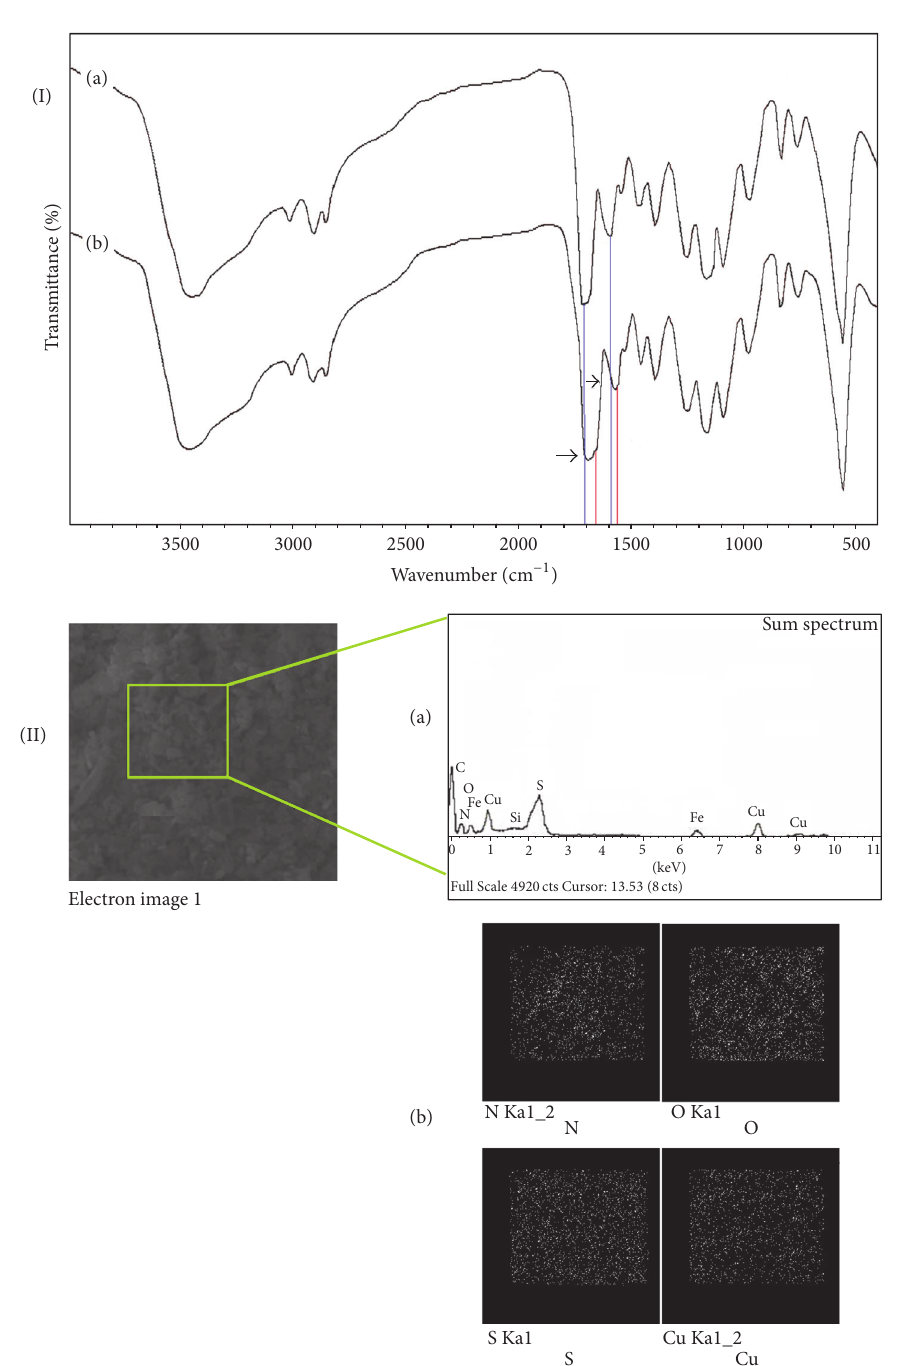
Figure 10: (I) FT-IR spectra of (a) prepared magnetic nanocomposite and (b) complex of nanocomposite-Cu. (II) (a) EDX analysis and (b) EMA image of the nanocomposite-Cu(II)